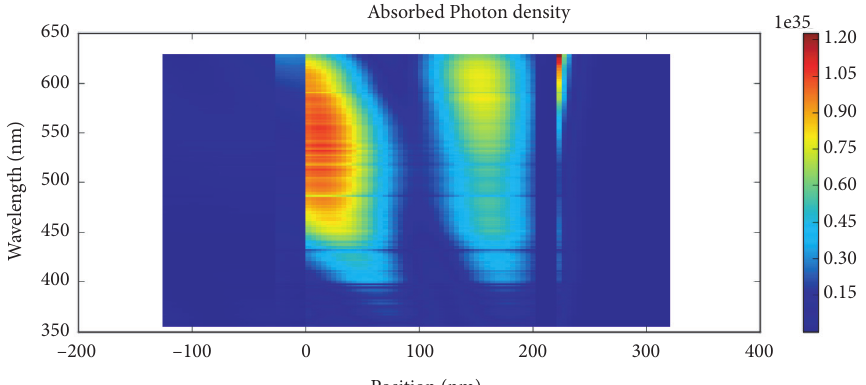
Figure 5: Absorbed photon density in different components of the device architecture of ITO/V2O5/PTB7: PC70BM/TiOx/Al. Table 2: Evaluated parameters of the cells for various active and interface layers. Active